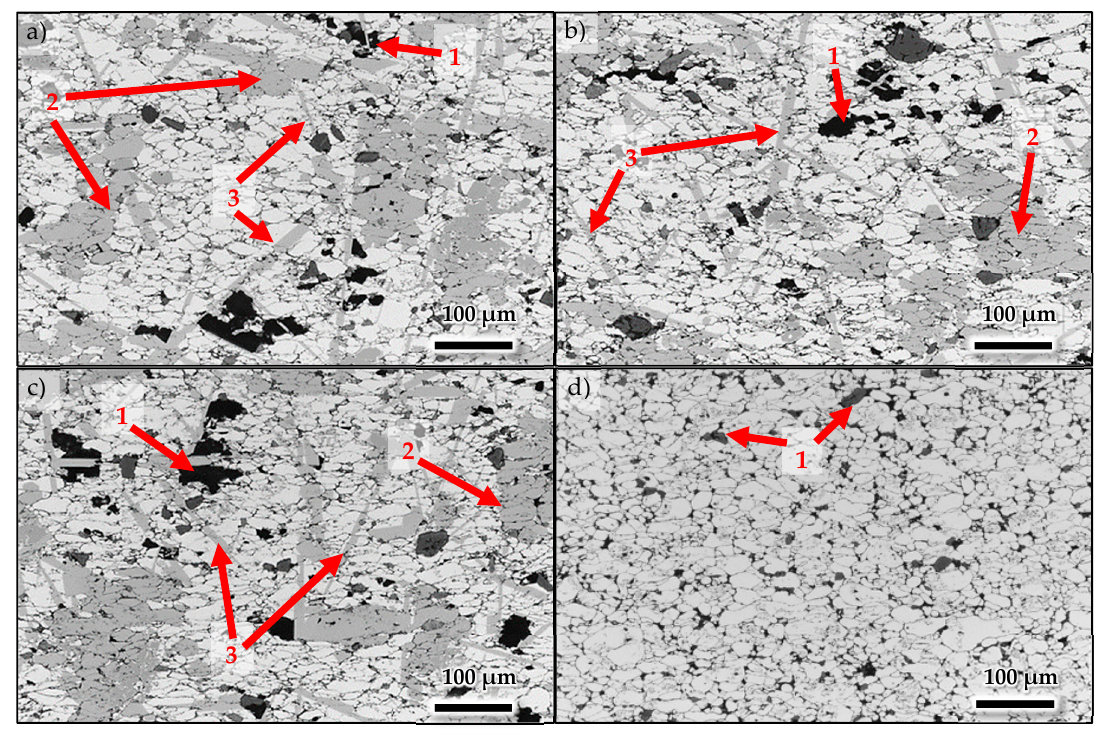
Figure 1. Microstructure of PIT Al-xCe wt %: x = ( a ) 8, ( b ) 10, ( c ) 12 and ( d ) 14.